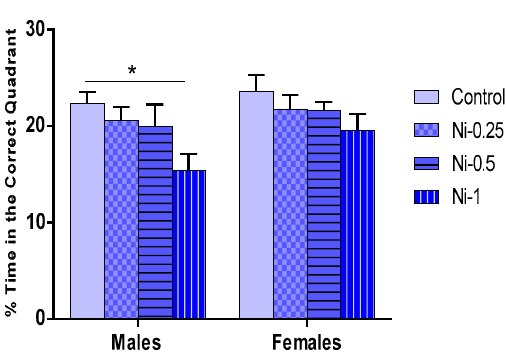
Figure 5. Percentage of time spent in the correct quadrant in the probe test of the Morris water maze expressed as % in male and female rats after 8 weeks of treatment with 0.9% of NaCl (Control), 0.25 mg/kg (Ni-0.25) 0.5 mg/kg (Ni-0.5), and 1 mg/Kg (Ni-1) of Ni. Results are represented as mean ± SEM. The significance level is 0.05. * p < 0.05.